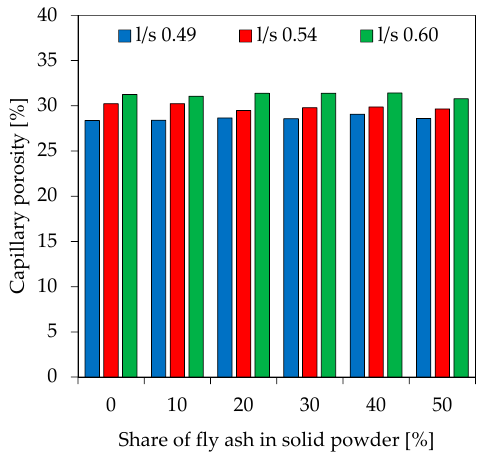
Figure 11. Capillary porosity of geopolymers (water adsorption tests).